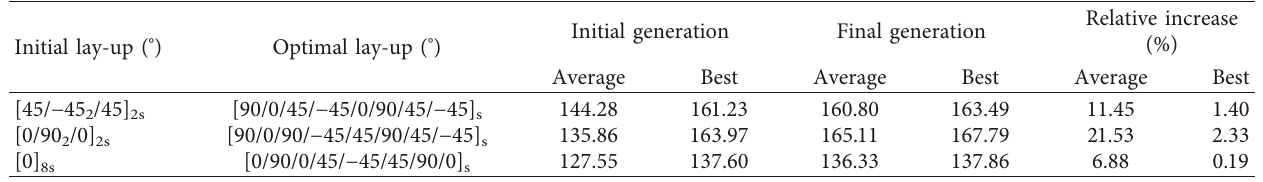
Table 5: Optimization results of the second phase optimization for Shell 1 (Hz).